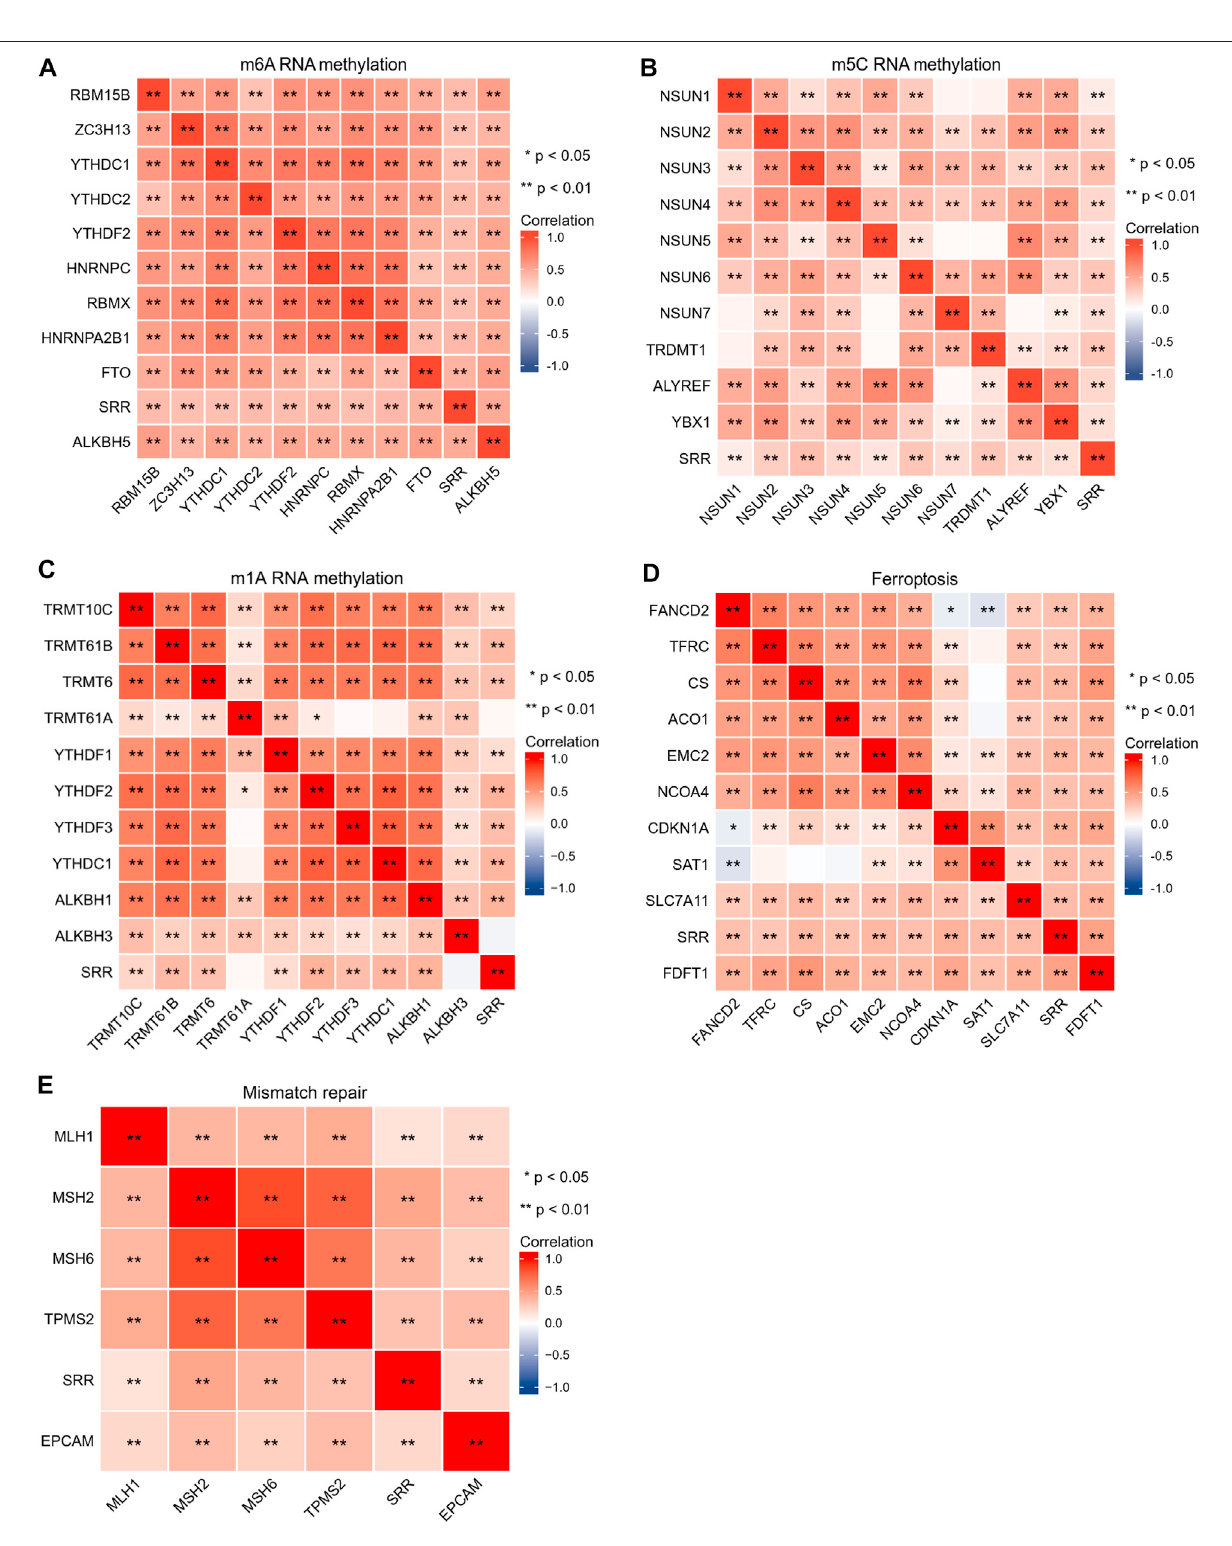
Frontiers in Genetics | www.frontiersin.org July 2022 | Volume 13 | Article 906291